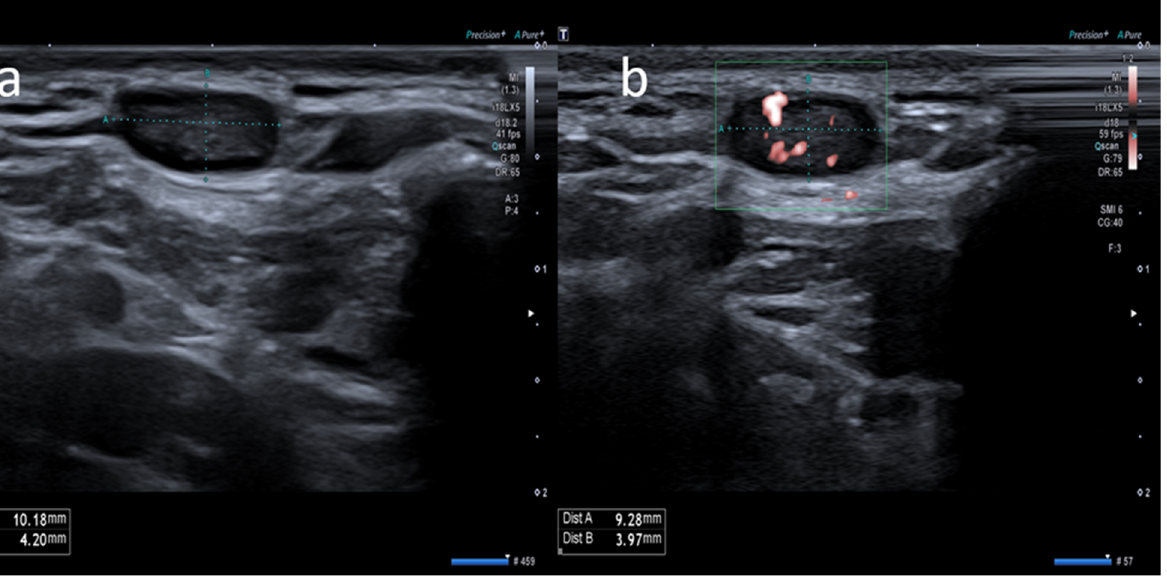
Figure 5. A 63-year-old female with palpable unilateral subclavicolar adenopathy noted four days after receiving the sec- ond dose of the AstraZeneca COVID-19 vaccine in her left deltoid muscle. ( a ) B-mode sonogram image shows ovalar hypoechoic lymph node with symmetric cortical thickening and hilum evidence. ( b ) SMI image shows central and periph- eral vascularization.